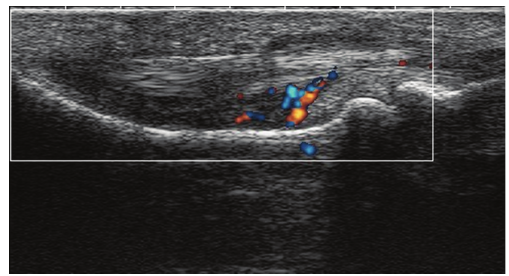
Figure 2: US-PDS scan. Index finger flexor tenosynovitis with fluid, thickening, and vascular